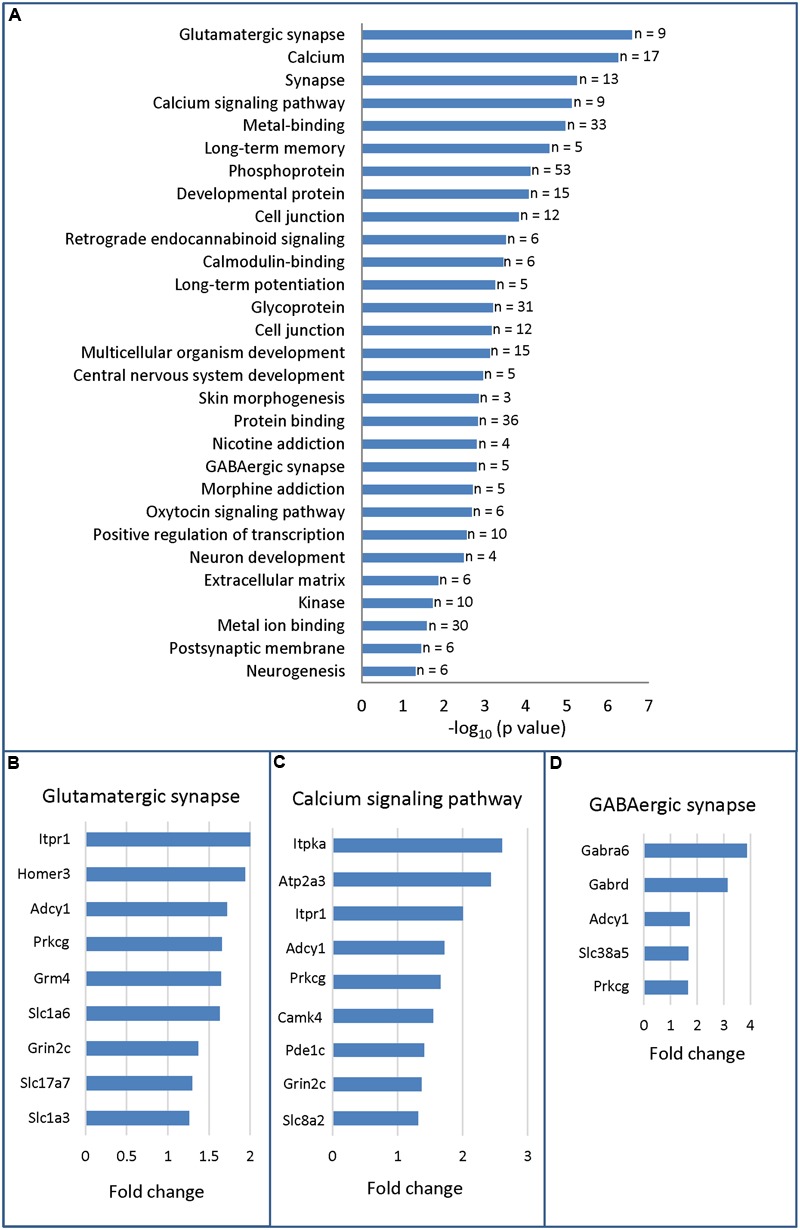
Gene ontology analysis (DAVID 6.7) of RNA-sequencing data from P21 brainstem in Hoxa5 control and Hoxa5 cKO. (A) Functional annotation chart. Significantly enriched terms (p < 0.05) associated to differentially expressed transcripts are presented in descending order (–log10 of p-value in x-axis). As detailed in Supplementary Table S4, p-values of the significantly enriched terms vary between 2.6 × 10-7 and 4.6 × 10-3. The number of genes for each term is indicated on the right. (B) Genes identified in the glutamatergic synapse term. (C) Genes identified in the calcium signaling pathway term. (D) Genes identified in the GABAergic synapse term. Fold change (x-axis) in (B–D) is the ratio between transcript abundance value measured in Hoxa5 control and transcript abundance value measured in Hoxa5 cKO in RNA-Seq analysis (see Supplementary Table S3 for detailed values).